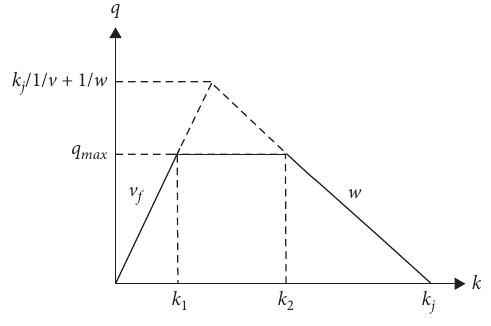
Figure 1: Flow density diagram in CTM.